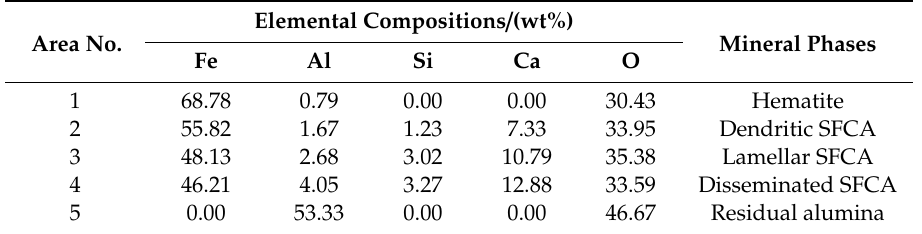
Figure 10. E ff ect of free state alumina on the characteristics of the bonding matrix (P: Pore; a → b: Rotate 90 ◦ to the right; ( a , b ) are the optical and SEM photographs of the reaction interface respectively; ( c ) is the of the photograph of line scan in ( b )). Table 5. EDS analysis results for areas in Figure